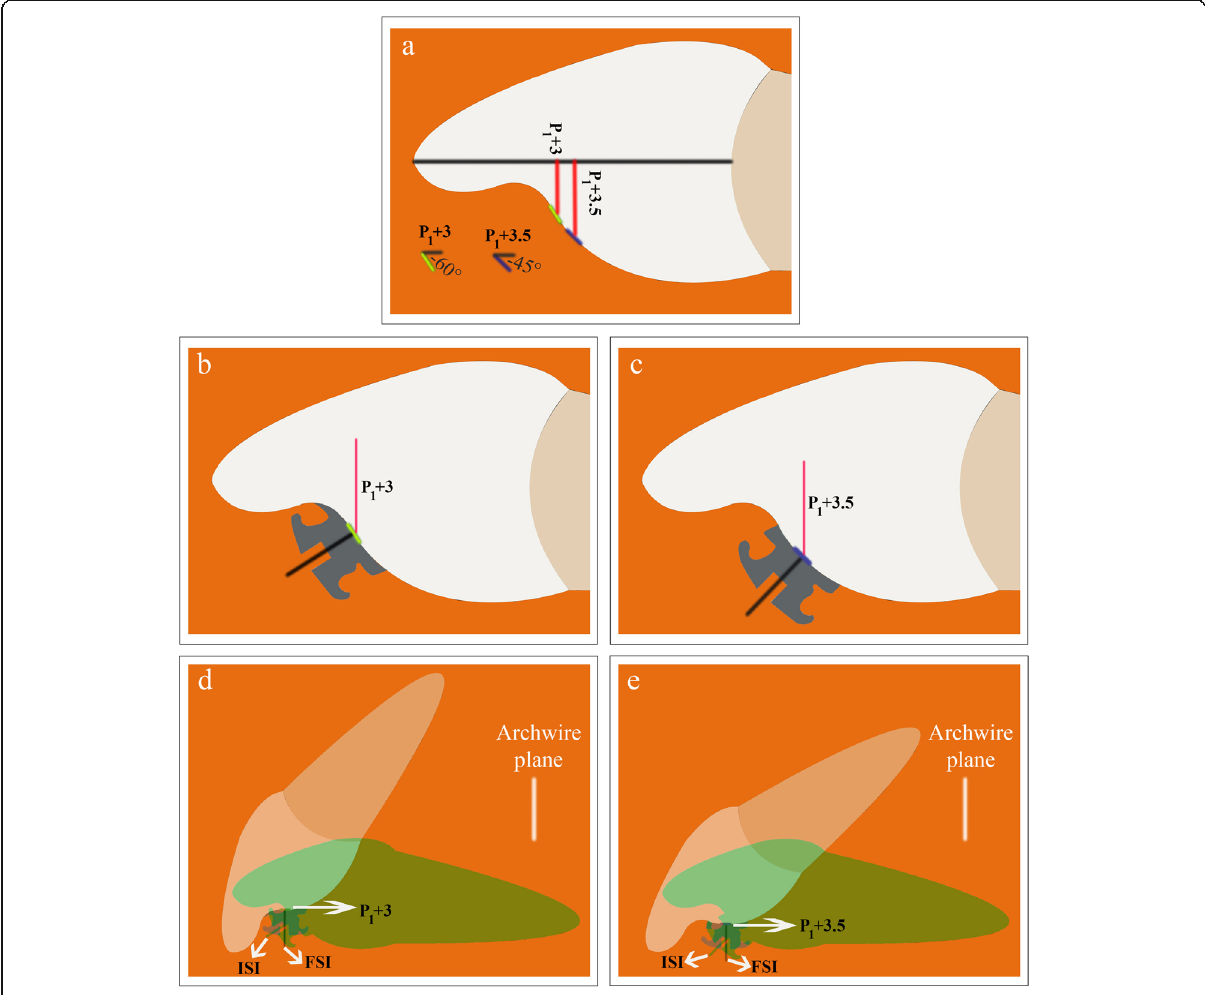
the increments [P + 3] and [P + 3.5] of the RMCI in 1 1 Fig. 7b are cervical to the inflection point while in the incisor of Fig. 7d those two increments are incisal to it. The anatomical variation in increment location with re- spect to the inflection point between incisors leads to distinctly different Torque Angle Values